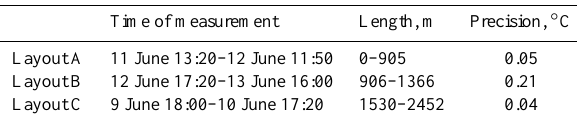
Table 3. Time of DTS stream bed temperature measurements with the length and precision of each